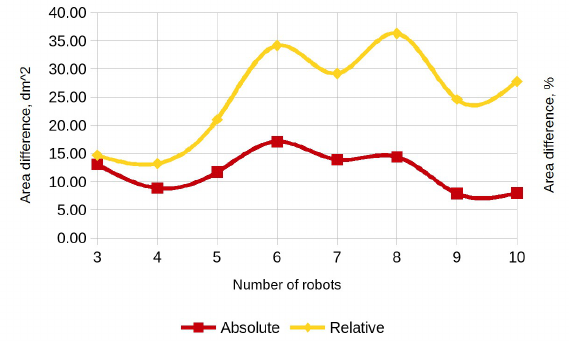
Figure 6: Absolute and relative area difference versus number of